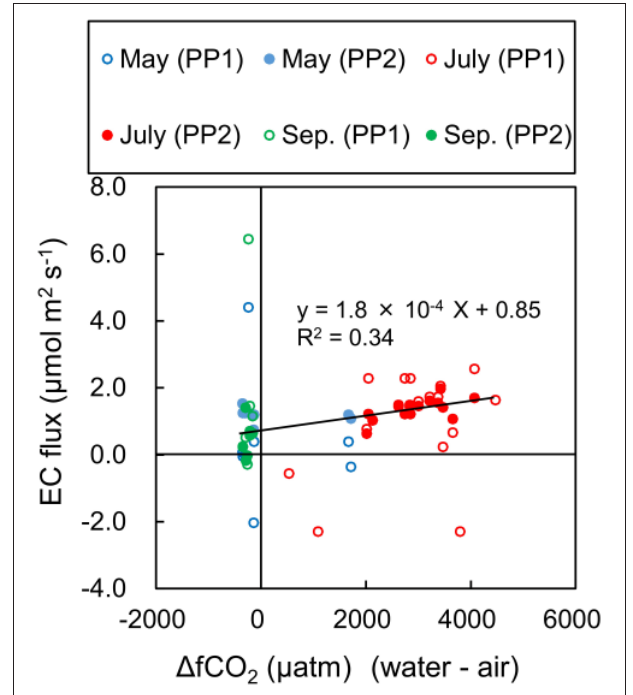
FIGURE 10 | Comparison of 1 fCO 2 (water minus air), EC flux with PP1 and EC flux with PP2. Significant linear relationship (solid line; P < 10 − 3 ) was observed after PP2, but not after PP1 ( P > 0.4).